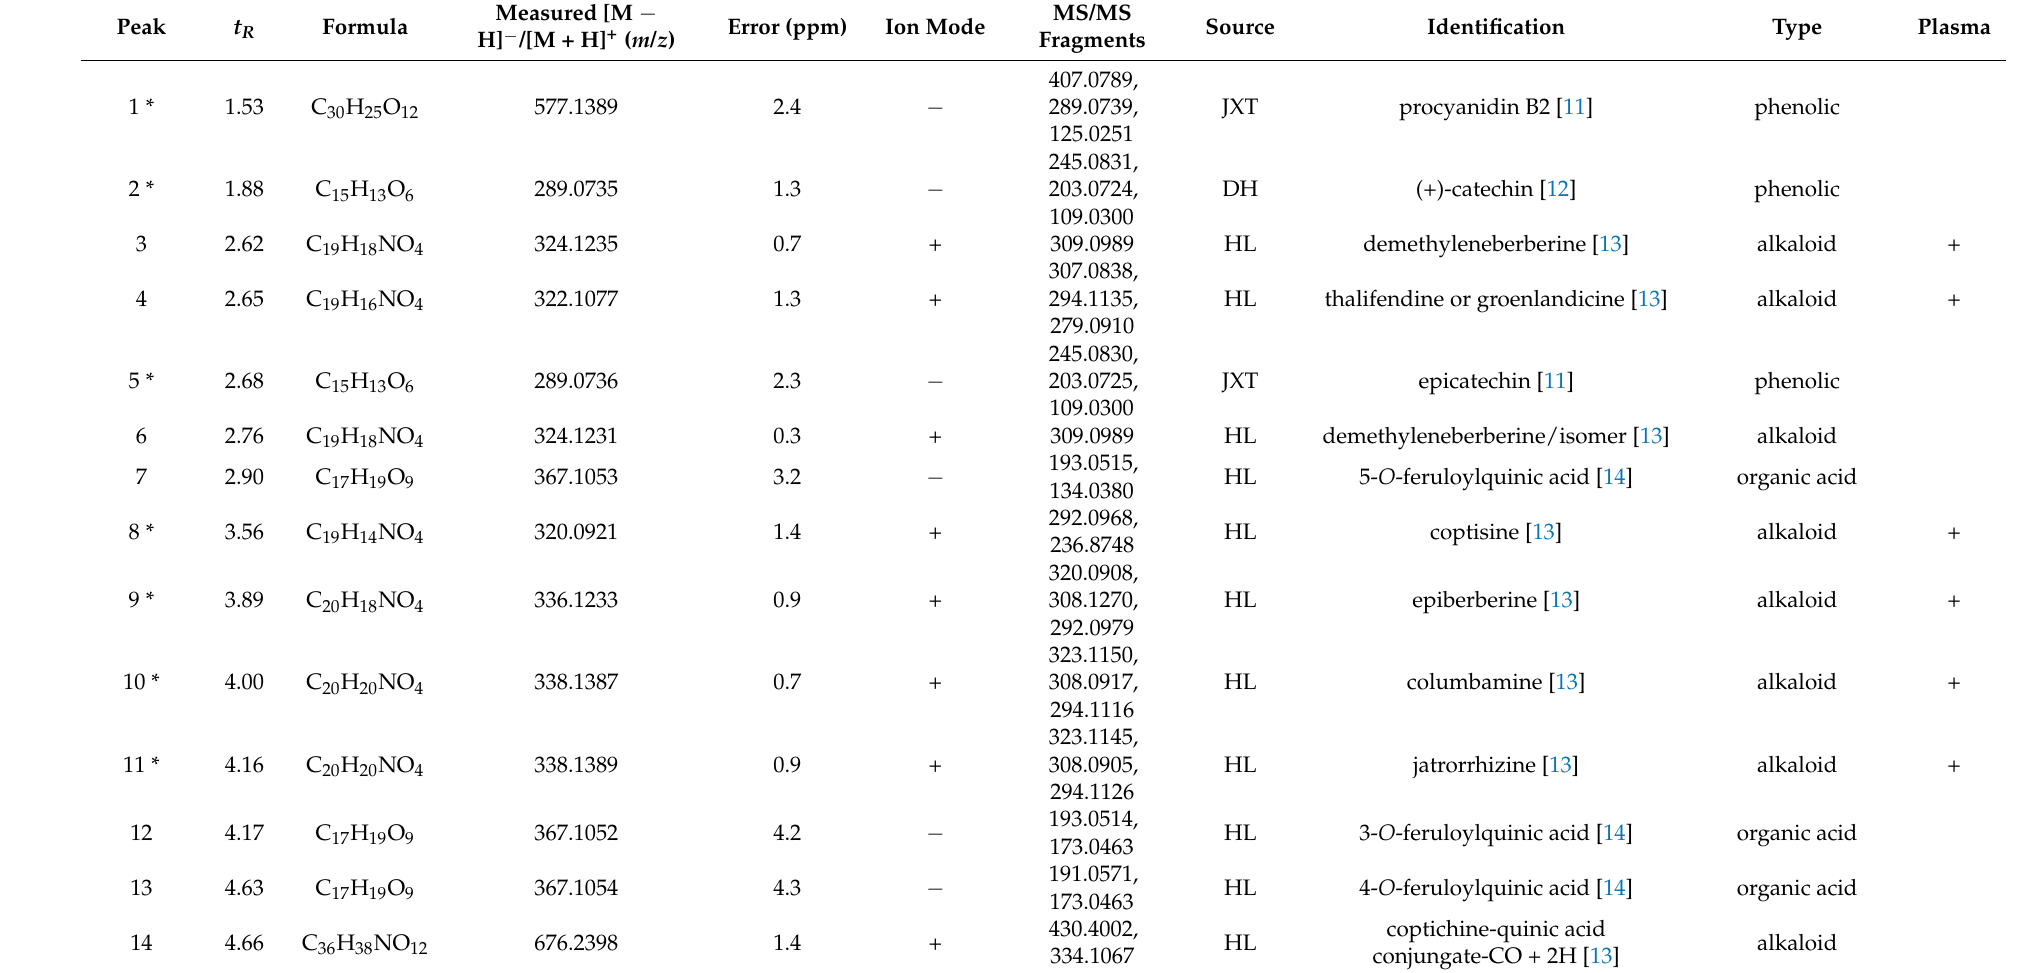
Table 1. Characterization of chemical constituents in GDL Pill by HRMS/MS